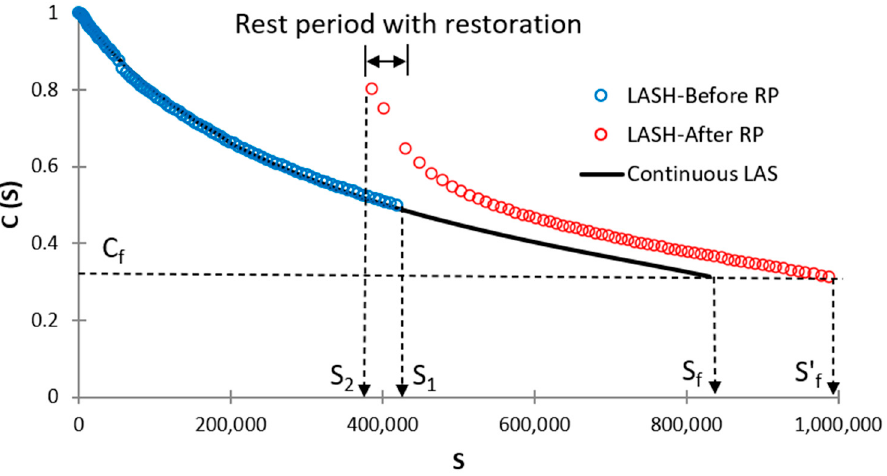
Figure 15. Schematic representation to identify 𝑆 (cid:3033)(cid:4593) and corresponding areas when conducting LASH (RP before or at 𝑆 (cid:3033) ). (RP before or at S f